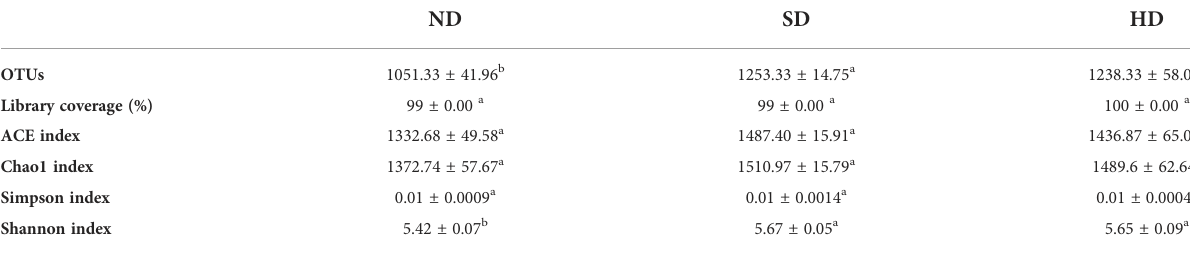
TABLE 3 Diversity of the soil bacterial communities of the non-degraded (ND), slightly degraded (SD) and heavily degraded (HD) alpine wetland areas.